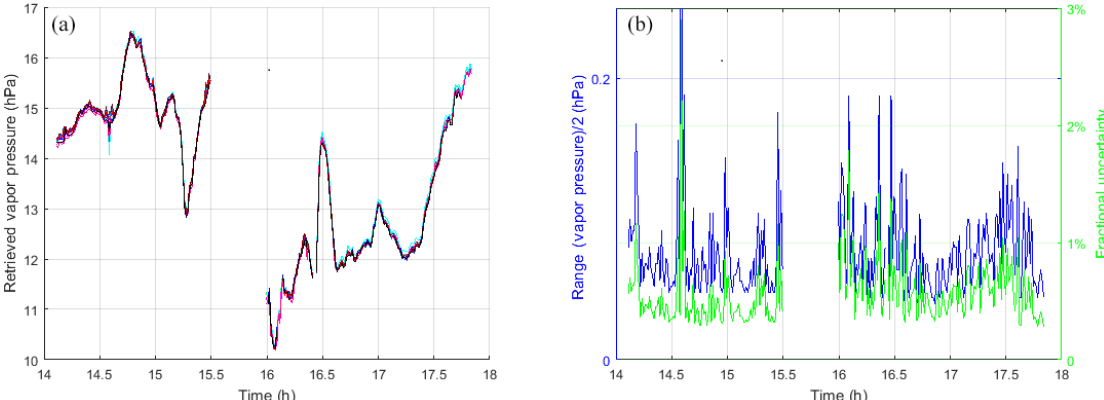
Figure 3. (a) Retrieved vapor pressure for the 12 retrieval test cases described in the text. Each line is a different color. (b) Blue line and left axis indicate the half range, which is half of the maximum minus minimum vapor pressure from the 12 retrieval cases; green line and right y axis is the half range divided by the absolute vapor pressure at each retrieval point expressed in percent. The strong peaks near 14.6h are due to momentary noise in the calibration signal.